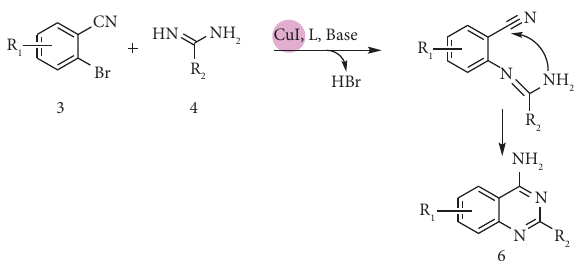
Figure 3: Te proposed mechanism for the synthesis of 4-ami- noquinazoline and 2,4-diaminoquinazoline analogues using CuI as a catalyst.